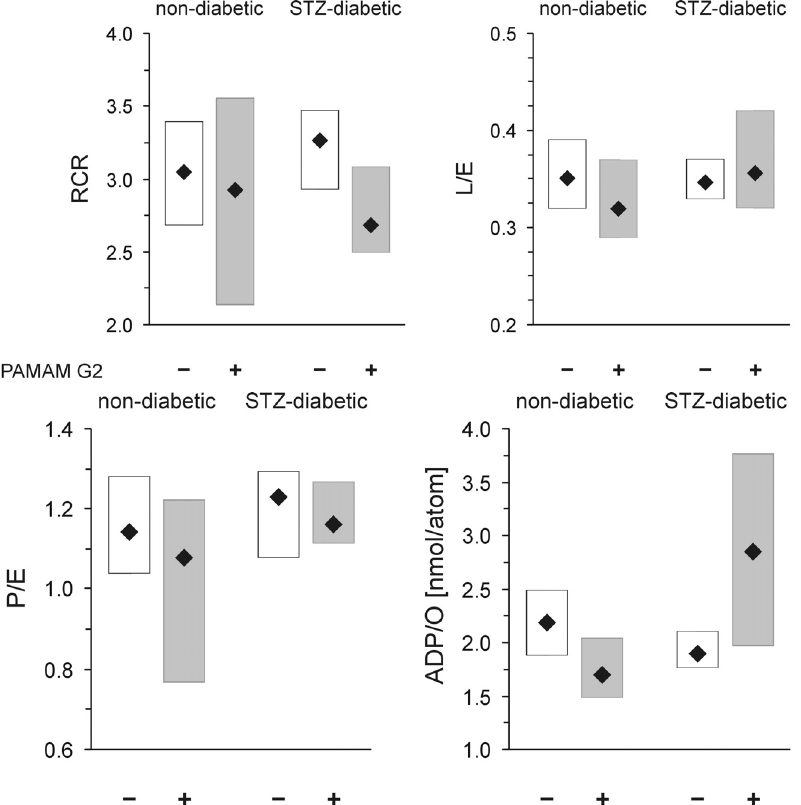
Figure 11. In vivo evaluation of the impact of PAMAM G2 on rat heart mitochondrial respiration. The data are expressed as median (diamonds) and lower-upper quartile range (rectangles); n = 8–20 animals. PAMAM G2 dendrimers (40 mg/kg/day) were administered to non-diabetic and streptozotocin-diabetic Sprague-Dawley rats for 60 consecutive days. The significance of differences was estimated using the non-parametric Kruskal-Wallis test followed by the Conover-Inman all-pairwise-comparisons test: * p < 0.03 “diabetic rats + vehicle” vs. “diabetic rats + PAMAM G2”; ** p < 0.0001 “healthy rats + PAMAM G2” vs. “diabetic rats + PAMAM G2”. Abbreviations : RCR, respiratory control ratio; L/E, leak control ratio; P/E, phosphorylation system control ratio; ADP/O, the amount of